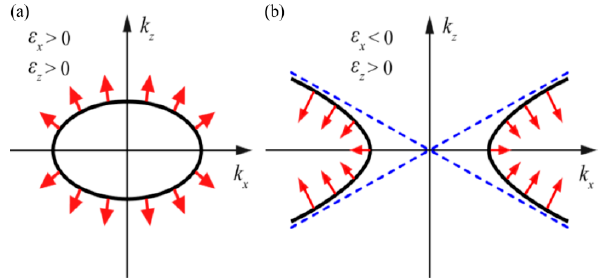
Figure 5. Hyperbolic equal-frequency contour (EFC) surface for metamaterial with ( a ) ε z > 0, ε x > 0; and ( b ) ε z > 0, ε x < 0. The group velocity is indicated by the arrows, which are perpendicular to the EFC.